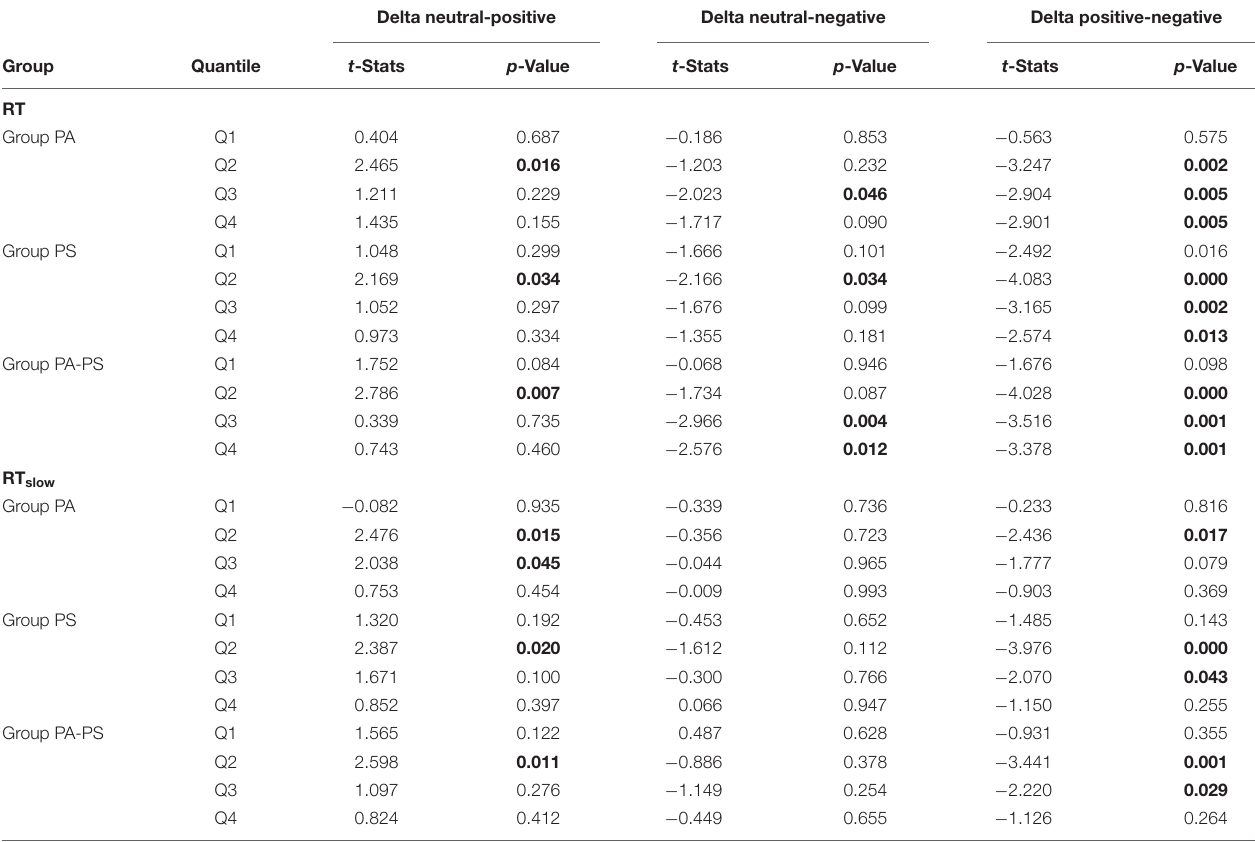
TABLE 4 | Delta plots (effect of ‘group’).